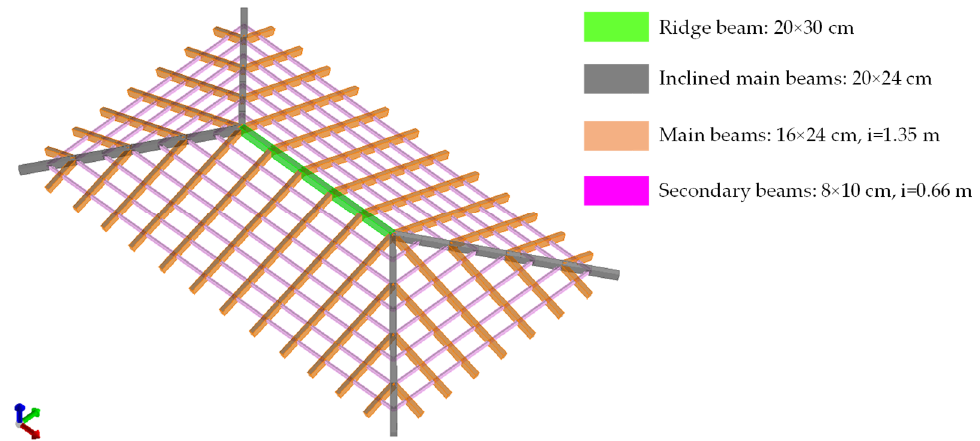
Figure 17. View of the new roof.